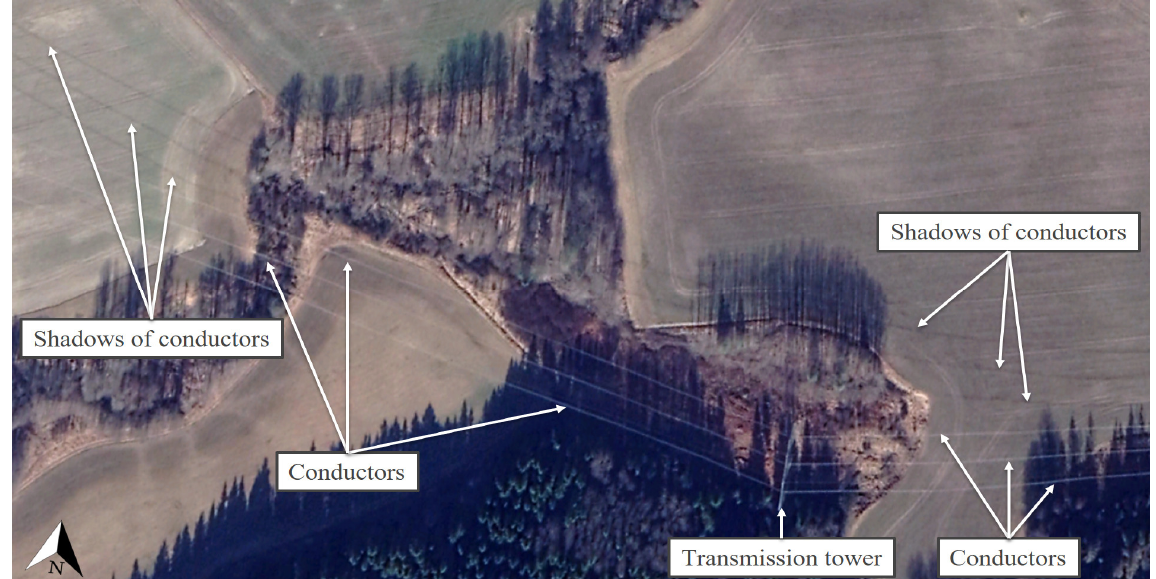
Figure 4. The layout of an 11 MWp PV system with high-voltage transmission towers and their conductors in Keszü (46.031793, 18.191574) on 2 February 2020 at approximately 11:30 a.m. (local time), based on [41].